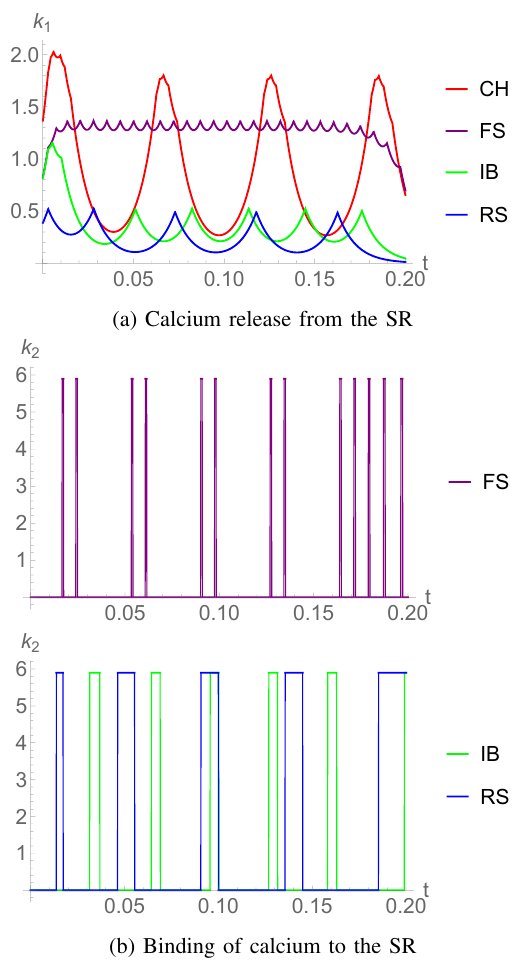
Fig. 4: Coefficients, corresponding to binding and un- binding of calcium to the